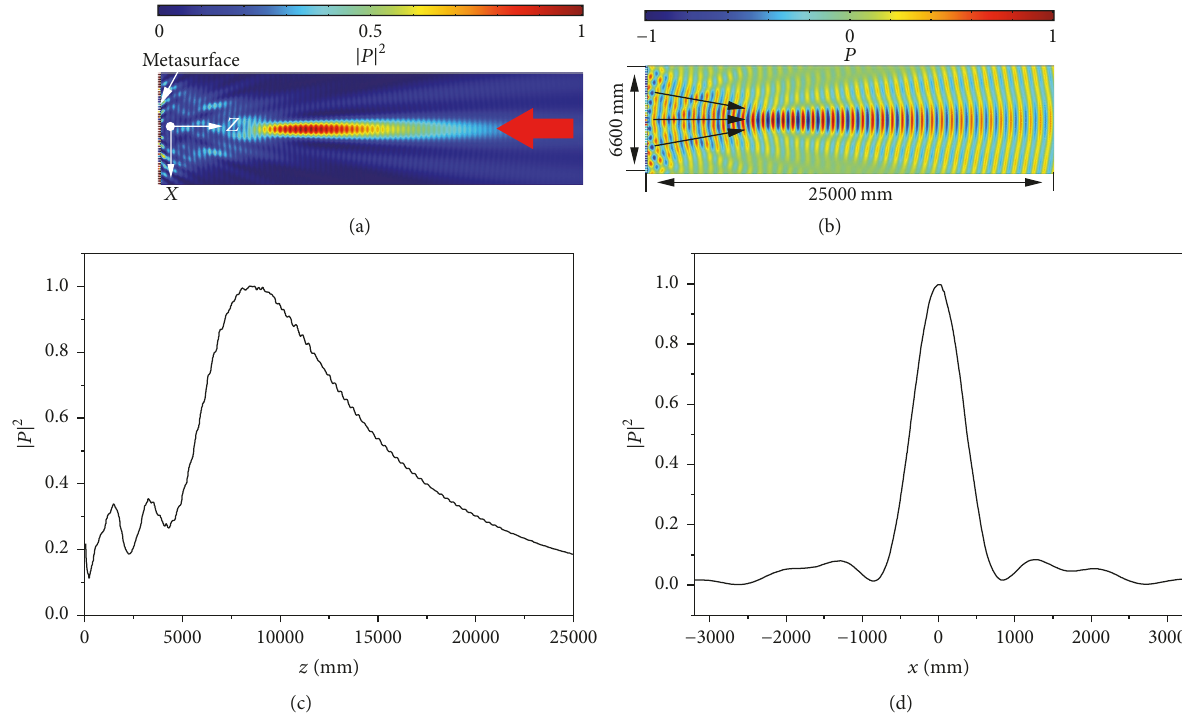
Figure 4: Acoustic axicon realized by the designed planar metasurface. (a) The normalized squared absolute pressure distribution of the reflected waves. The red arrow indicates the propagation direction of incident wave. (b) Transient sound pressure field distribution of reflected wave.Theblackarrowsrefertothereflecteddirections.Theanglebetweenequiphasesurfaceand 𝑥 -axisis10 ∘ .(c)Thelongitudinaldistribution of acoustic intensity at 𝑥 = 0 . (d) The transverse distribution of acoustic intensity at 𝑧 = 8500